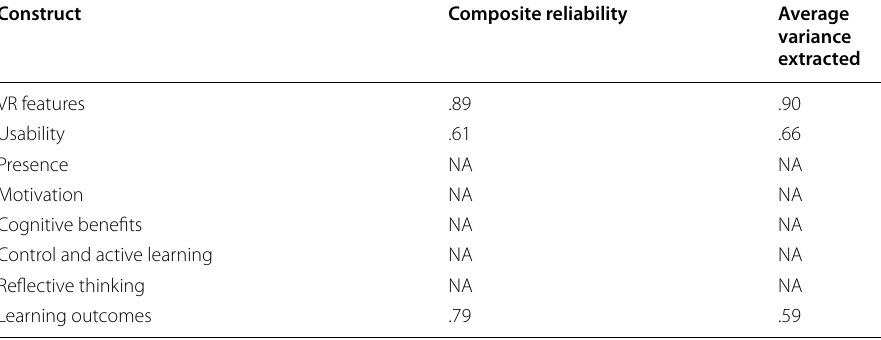
Table 3 Internal consistency of the measurement